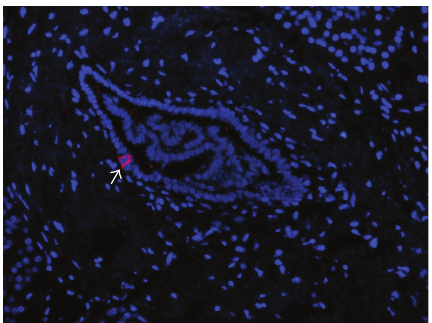
Figure 2: Section of human pancreatic exocrine tissue stained with an anti-insulin antibody (red). Nuclei are stained by DAPI (blue). An insulin-positive cell (arrow) is detected in the duct lining suggesting a process of β -cell